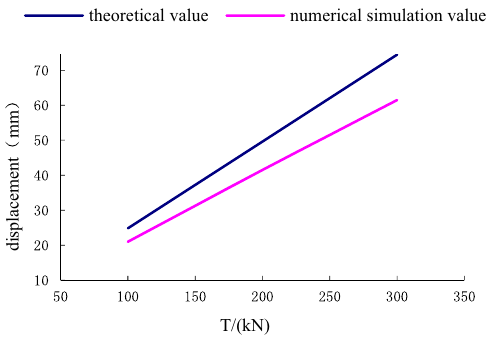
Figure 30. Comparison of theoretical calculation and numerical simulation results.